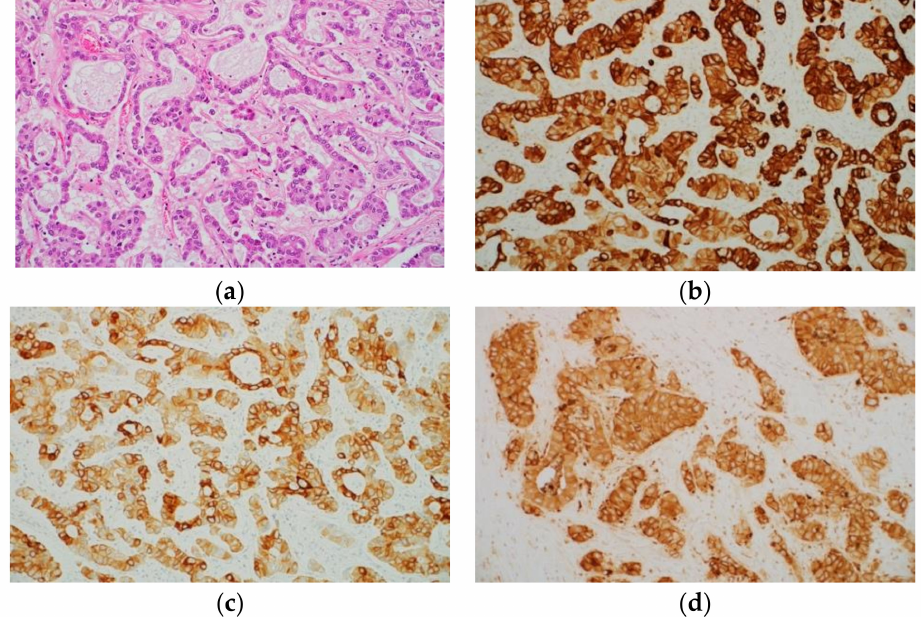
Figure 4. Histological appearance ( a ) and results of immunohistochemical staining ( b – d ) of intrahep- atic cholangiocarcinoma (ICC). ( a ) Histologically, ICC is an adenocarcinoma. Immunohistochemically, tumor cells are positive for cytokeratin (CK) 7 ( b ), CK19 ( c ), and carcinoembryonic antigen (mono- clonal antibody) ( d ). (Original magnification: × 200 for ( a – d